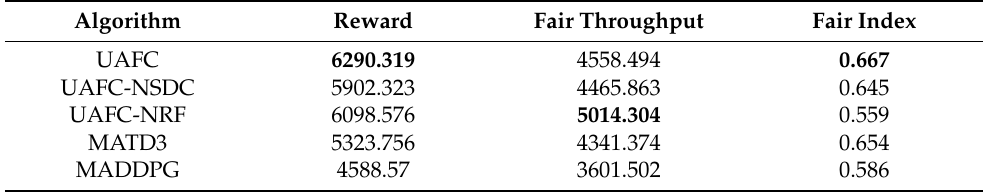
Table 3. Results of five algorithms on reward function, fair throughput, and fair index. Algorithm